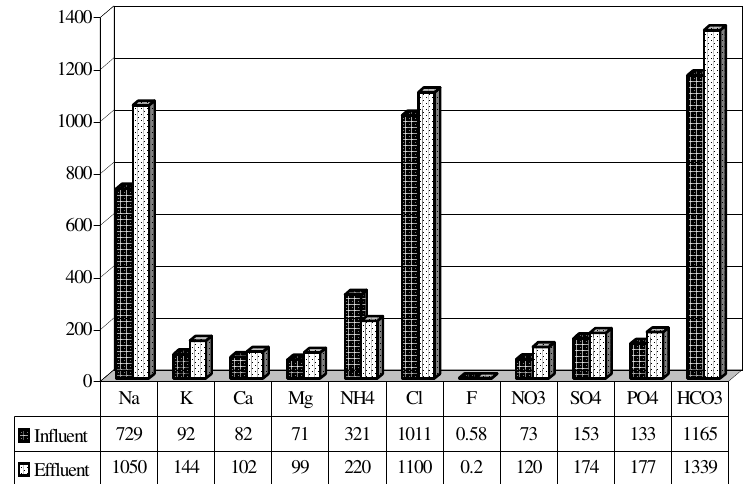
Figure 4 . The average concentration of the major cations and anions for influent and effluent wastewater in summer